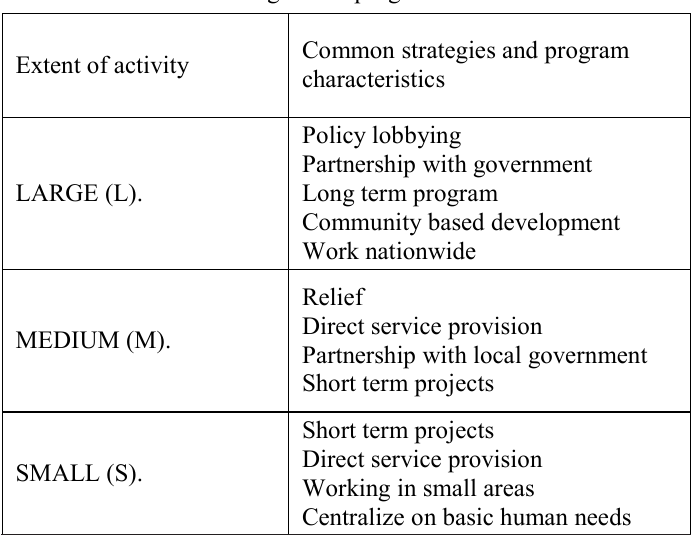
Table 3 - Common strategies and program